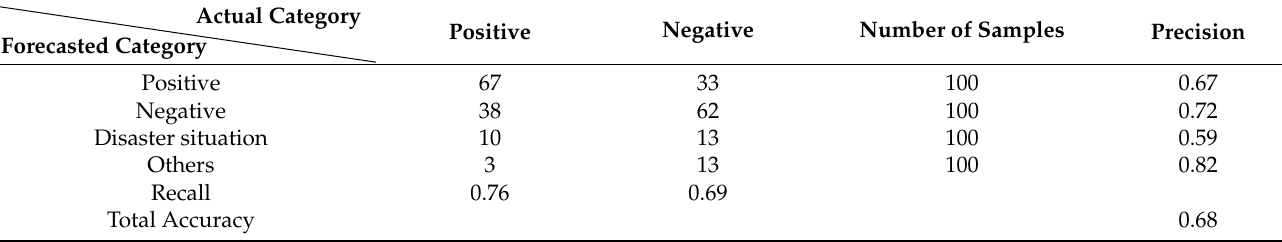
Table A4. Results of the manual test of the